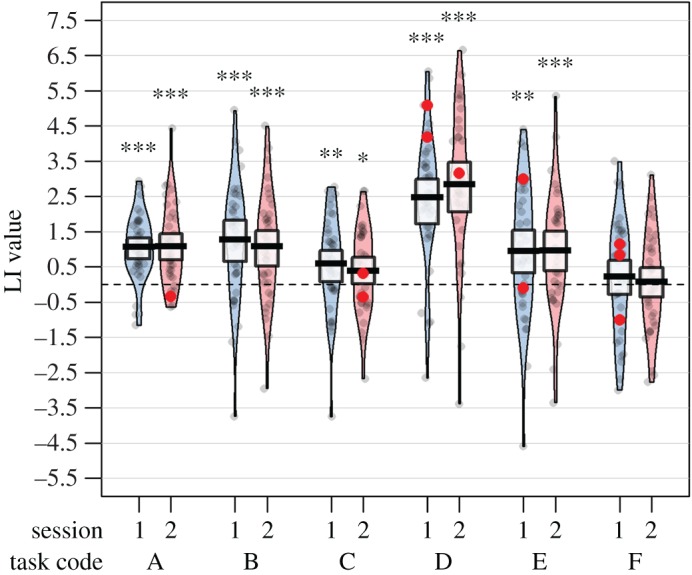
Pirate plot of LI values for all tasks (A–F) and sessions (blue = session 1, pink = session 2). Excluded data-points are shown in red. Asterisks show results of Wilcoxon tests comparing the LI values of the group (omitting excluded data-points) to zero (*p < 0.05; **p < 0.01; ***p < 0.001).